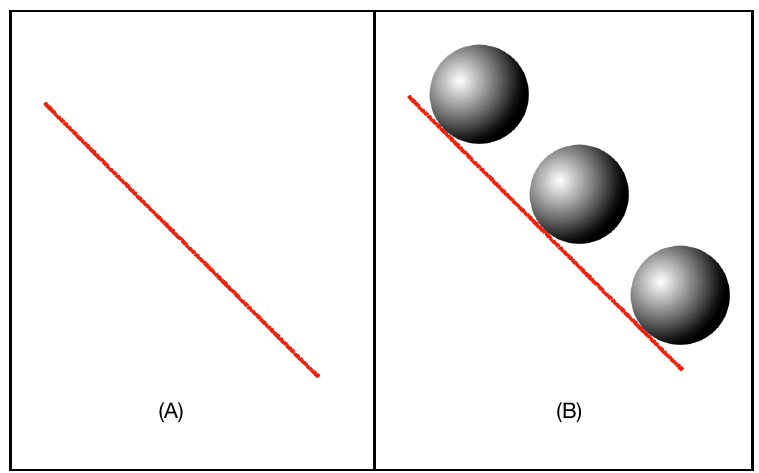
Figure 1 . Carroll fermions viewing I ± : (A) Lower fermions, (B) Upper